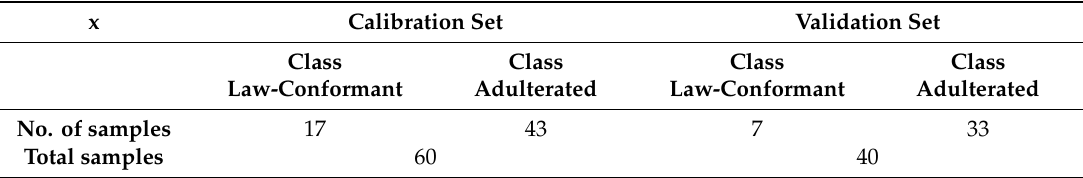
Table 2. Division of samples into calibration and validation sets.